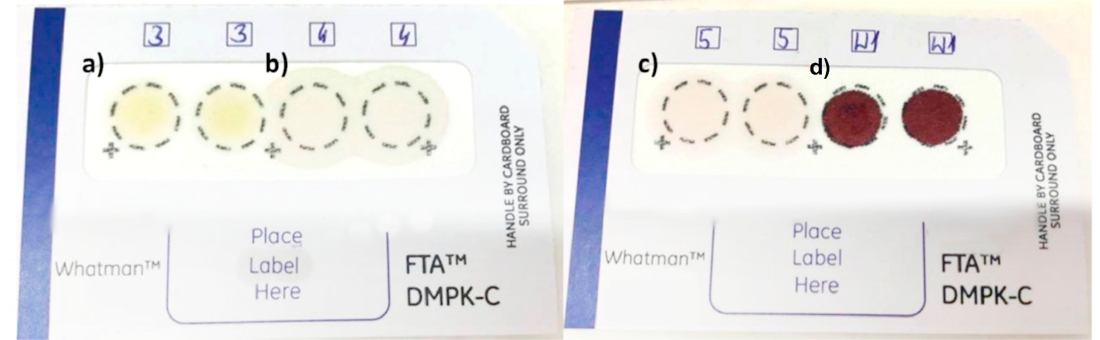
Figure 4. DBS cards with applied beverage samples ( a ) orange juice, ( b ) Coca-Cola, ( c ) rose wine, and ( d ) blood.